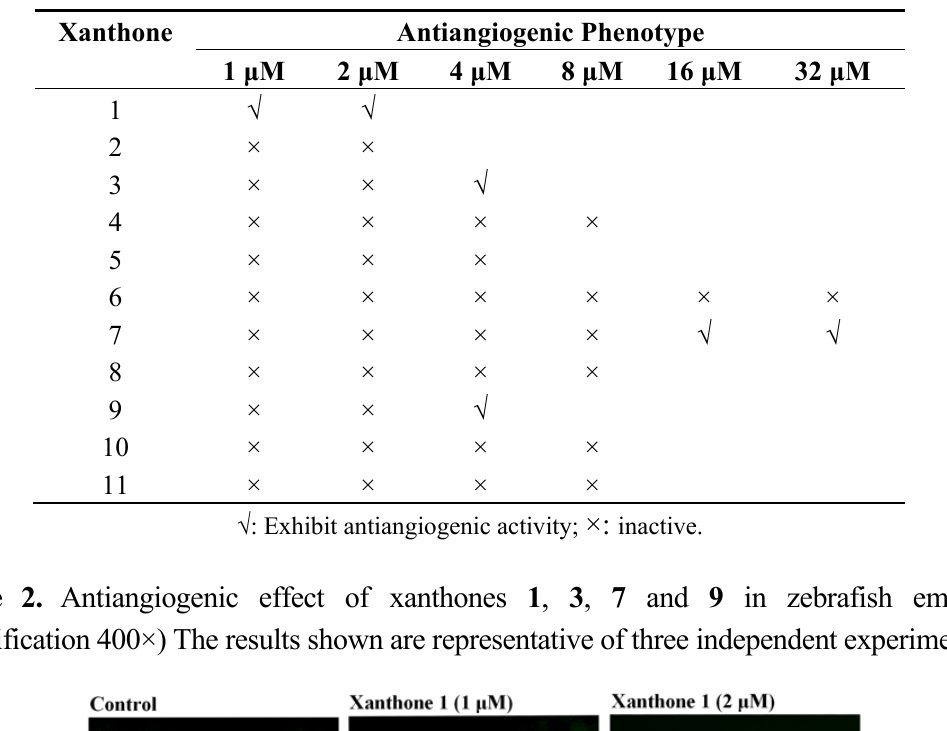
Table 2. Antiangiogenic phenotype of caged polyprenylated xanthones 1 – 11 in zebrafish embryos. The results shown are representative of three independent experiments.